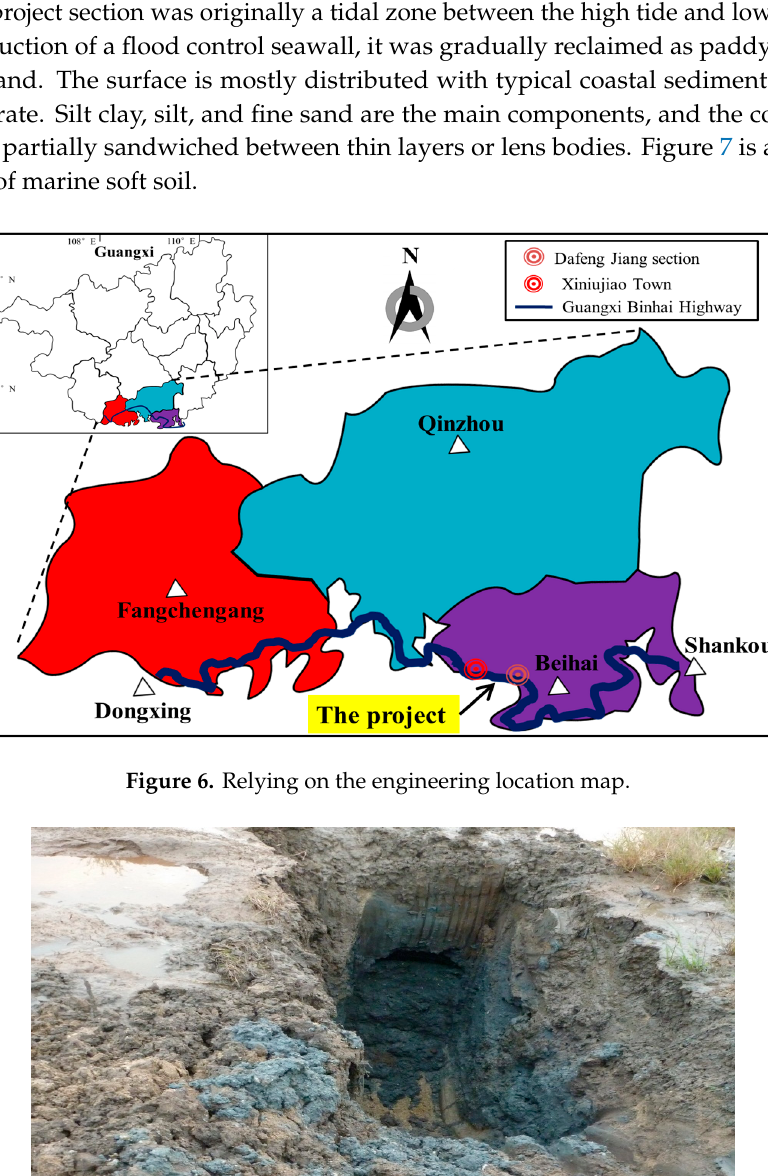
Figure 5. Location of the Guangxi Binhai Highway within China.